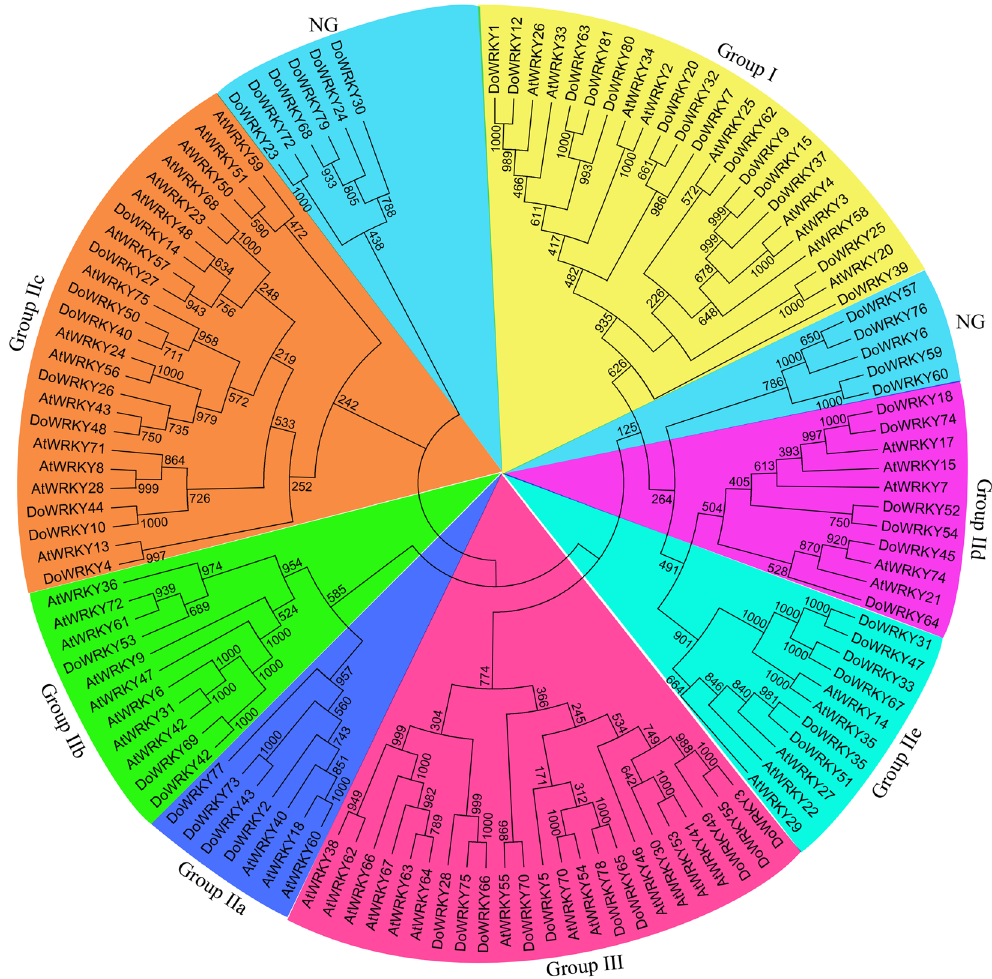
Figure 1. Unrooted phylogenetic tree of D. officinale and Arabidopsis thaliana WRKY proteins. The 63 DoWRKY proteins and 58 AtWRKY proteins were aligned by ClustalX 2.0 to generate a phylogenetic tree using the Neighbor–Joining method with 1000 bootstrap